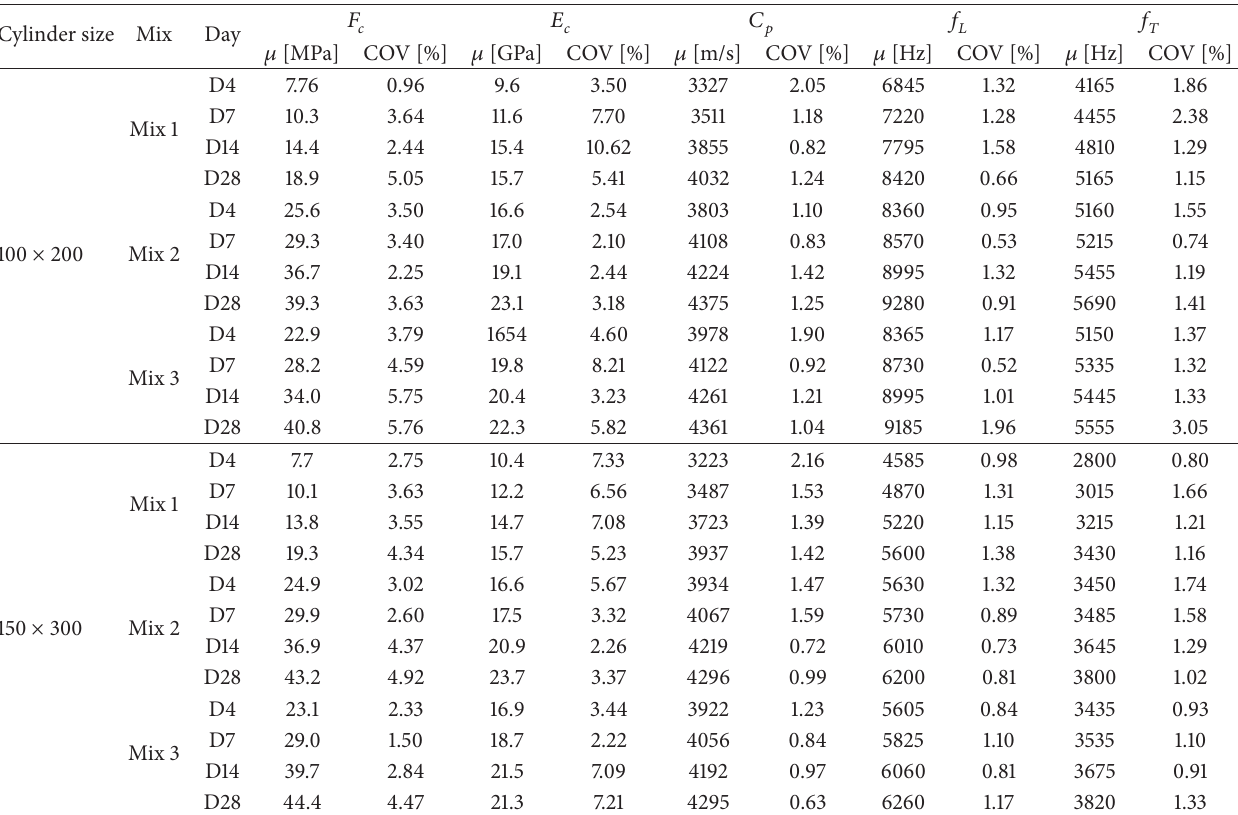
Table 2: Summary of test results measured from 100 by 200 mm and 150 by 300 mm